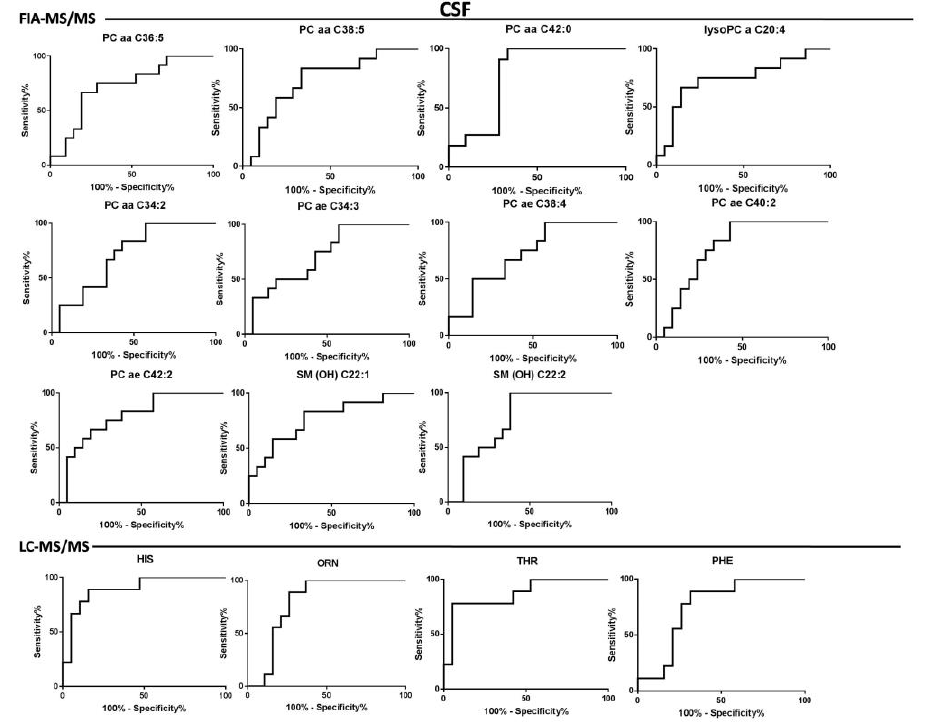
Figure 2. Univariate analysis. Bar-plot of the most discriminant metabolites resulting from the analysis of CSF and serum analyzed with FIA-MS/MS and LC-MS/MS. The black bar indicates the average concentration of the relapses and remissions (RRMS) class expressed as ranks, while the grey bar indicates the average concentration of the PPMS class expressed as ranks. Stars indicate significant change in the concentration of the metabolites.